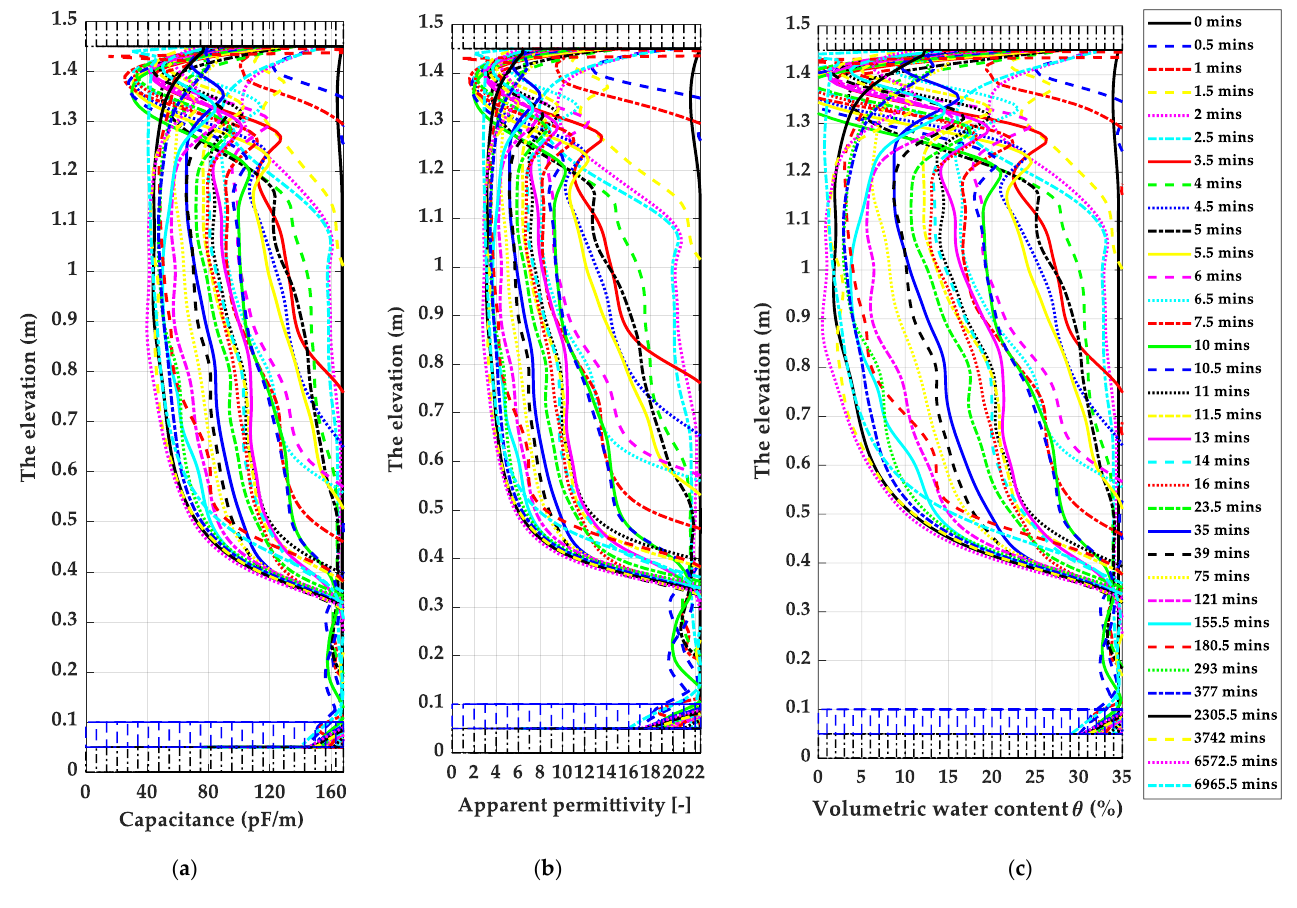
Figure 17. The demonstrations of reconstructed capacitance, apparent permittivity and volumetric moisture profiles ( C(x), ε app (x) and θ(x) ) for the selected soil column filled with Sebilco 30/60 sand using TDR inversion analysis: ( a ) C(x) ; ( b ) ε app (x) ; and ( c ) θ(x) .